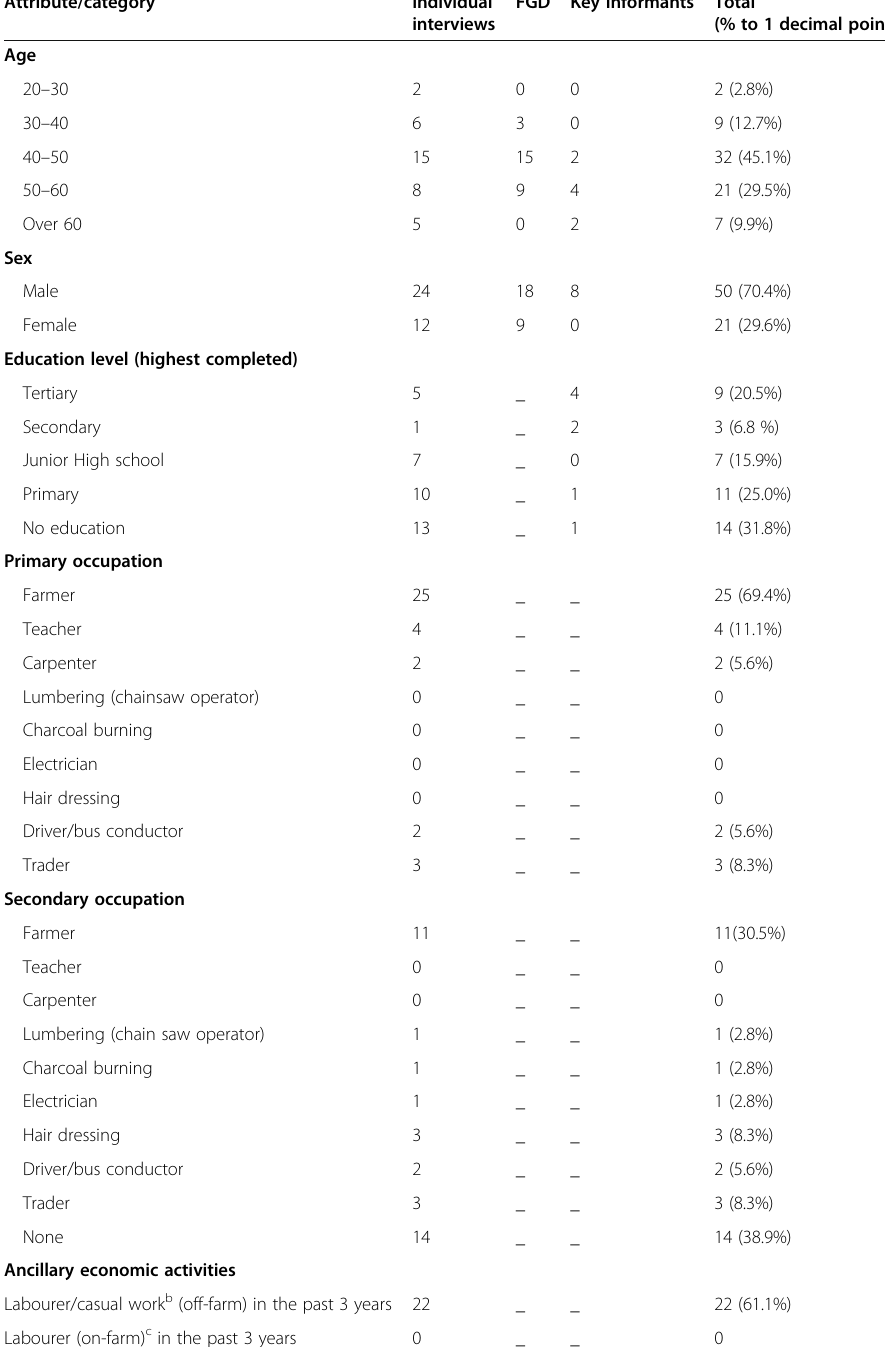
Table 3 Demographic characteristics of respondents: summary